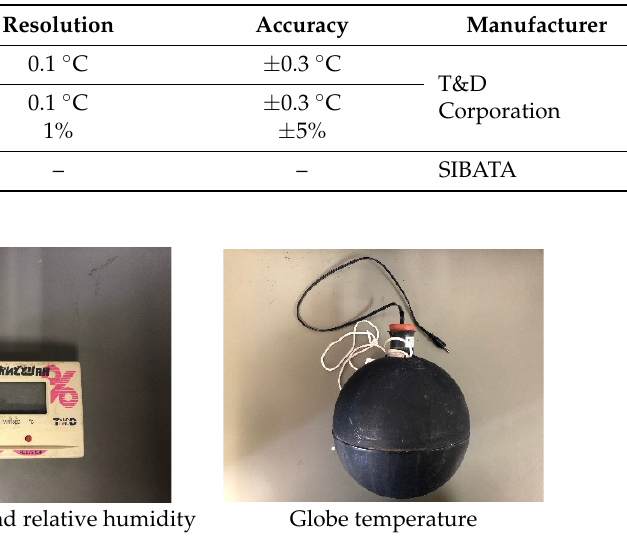
Figure 2. Measurement instruments used.